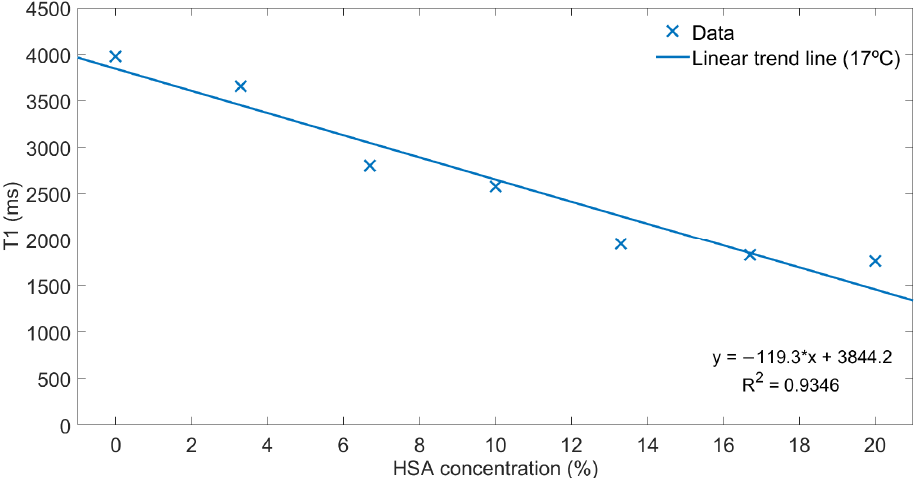
Figure 3. Relationship between T1 values and HSA concentrations in the 7 phantoms at 3T.